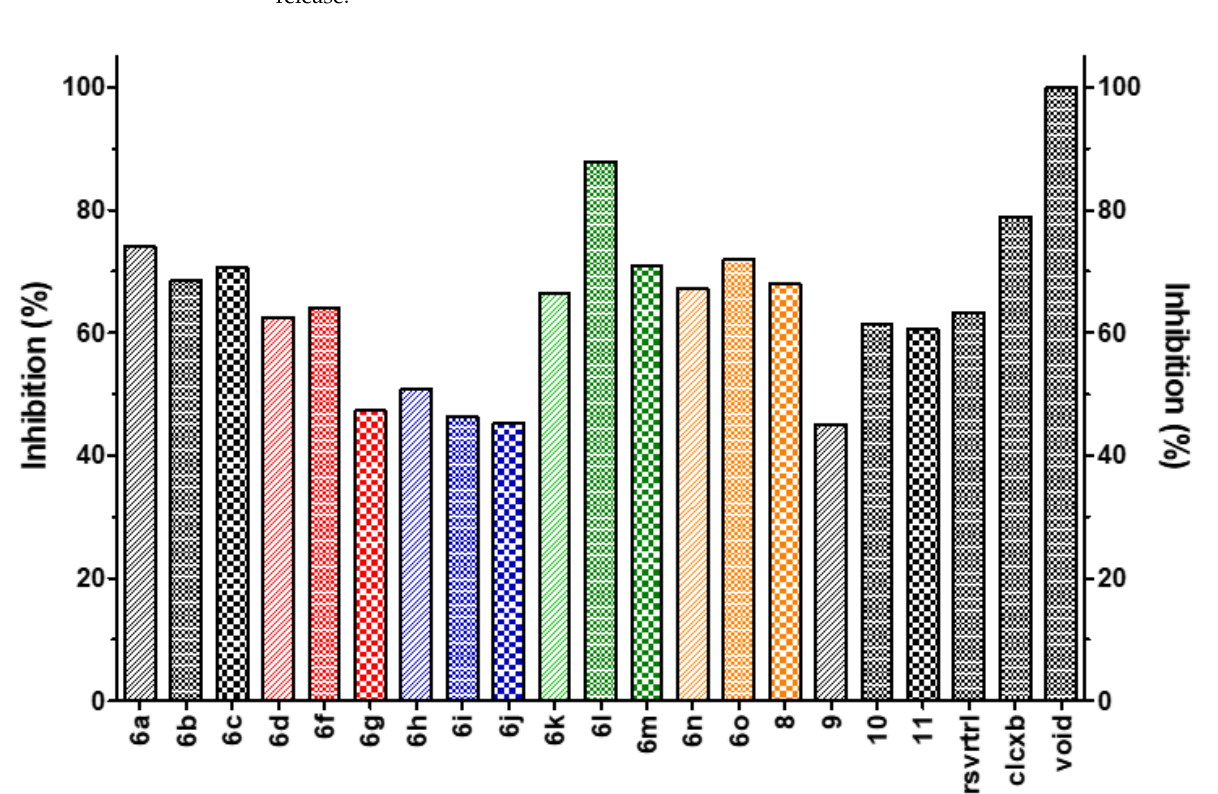
Figure 5. COX-2 inhibition assay results. Compounds were tested at a concentration of 22 μ M.